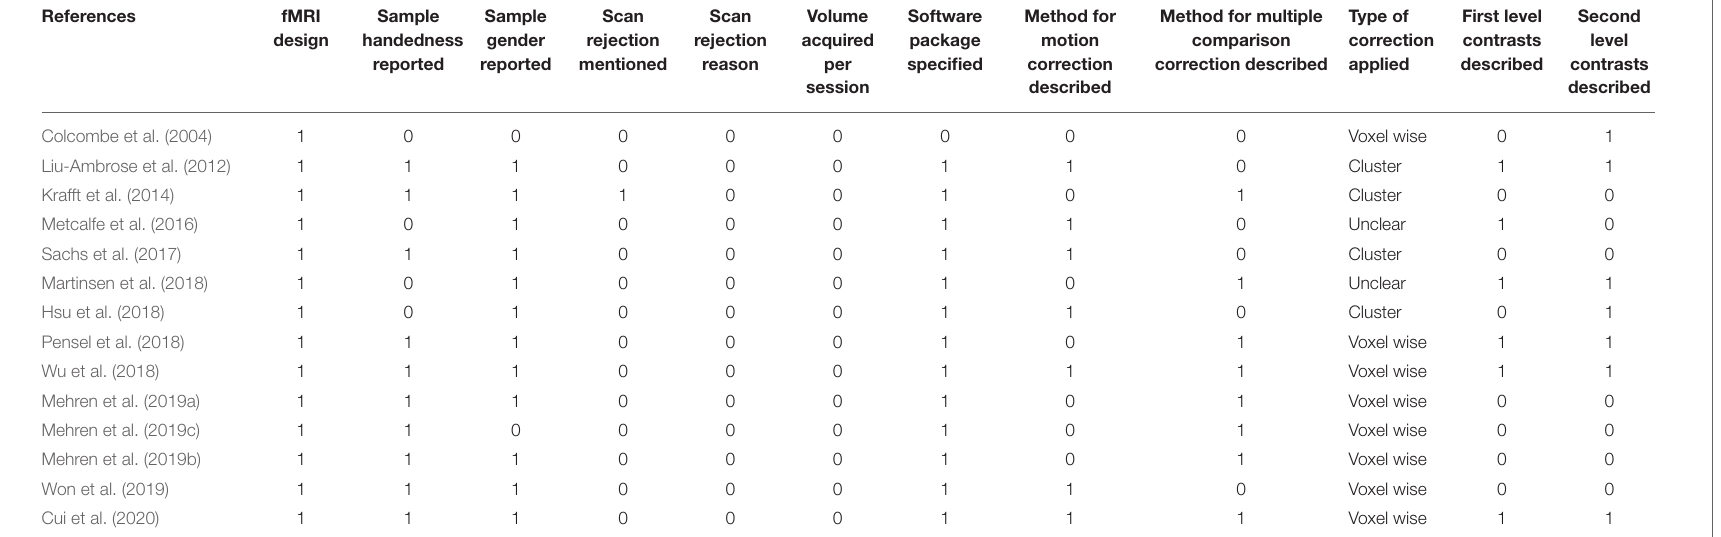
TABLE 3 | fMRI quality assessment of included